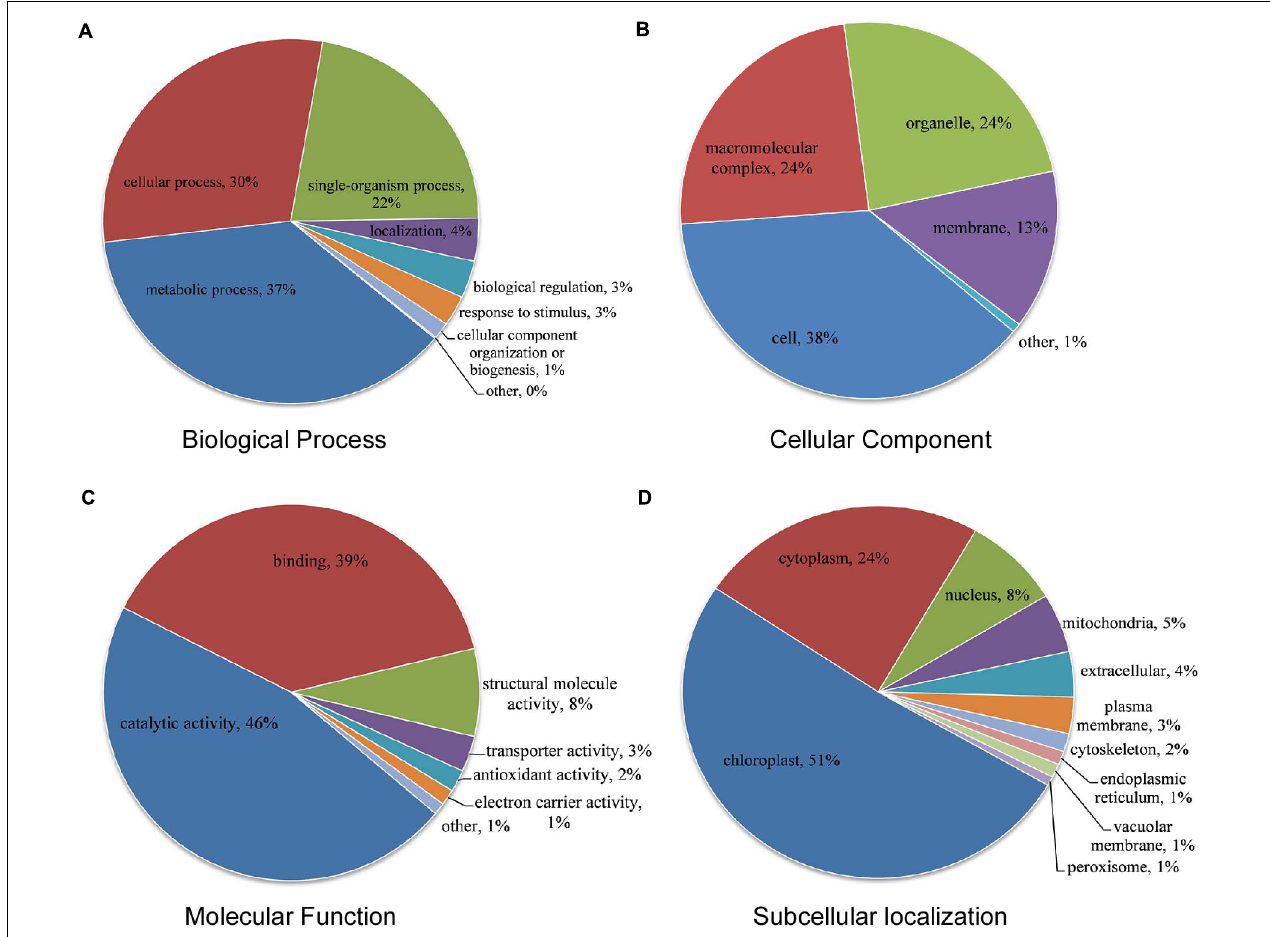
FIGURE 4 | Functional distribution and subcellular localization of lysine acetylated proteins in CWMV-infected N. benthamiana . (A) Lysine acetylated proteins classification according to their biological process. (B) Lysine acetylated proteins classification based on their cellular component. (C) Lysine acetylated proteins classification according to their molecular function. (D) Subcellular localization of lysine acetylated